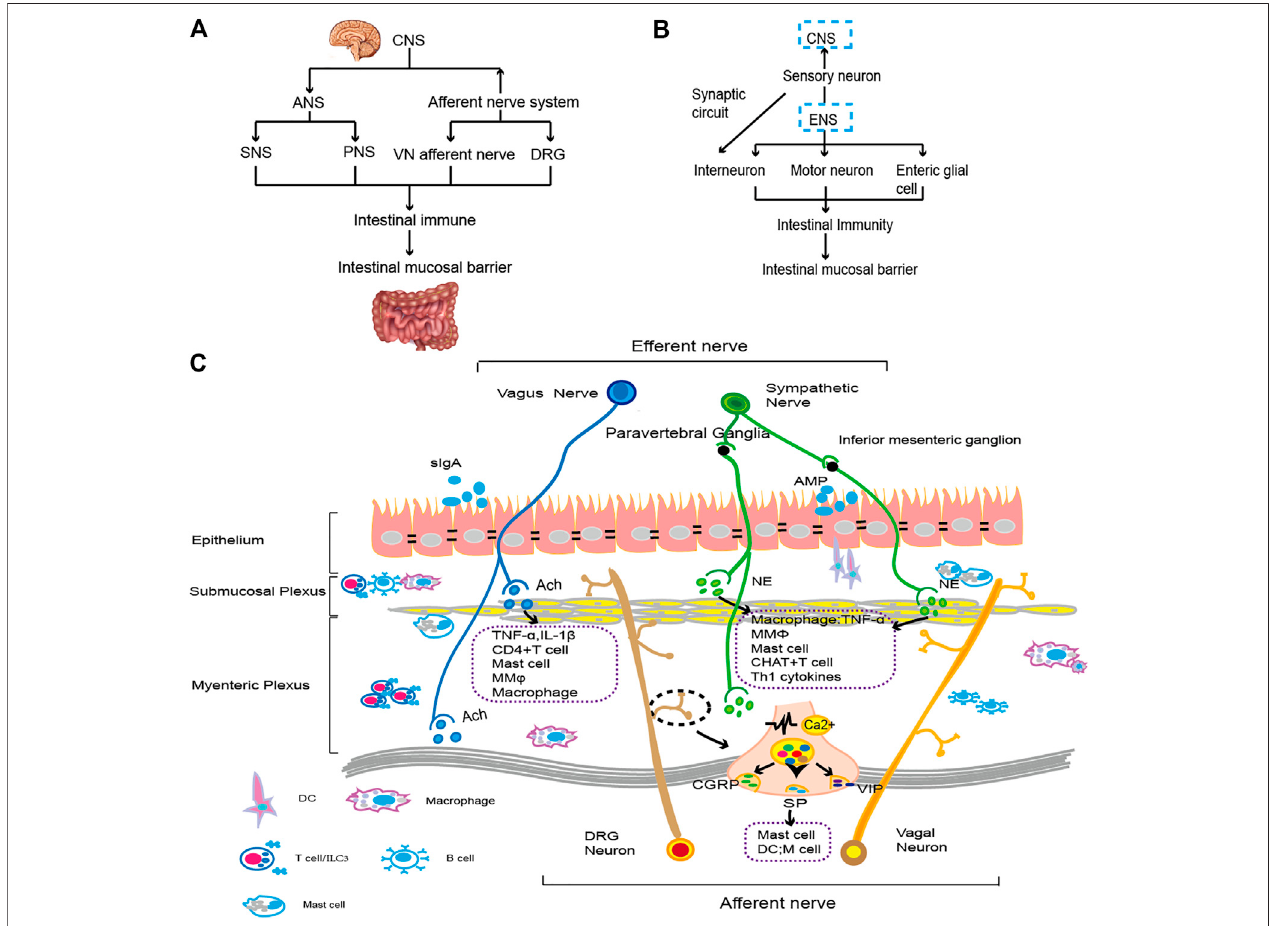
FIGURE 1 | The gut brain axis and neuroimmunity. (A) . The CNS connects with the intestine through the ANS and afferent nerves. By regulating immune cells and cytokines, itaffects the function ofthe intestinal epithelial cell barrier. The speci fi ctypes of immune regulation are shown in (C) . (B) . The ENS transmits information to the CNS through sensorynerves.Moreover,motorneurons, intermuscularneuronsandintestinalglialcellsoftheENS interact withintestinal resident orexogenousimmune cells and then affect the composition and function of the intestinal mucosal epithelial barrier. The speci fi c immune types are shown in (C) . (C) . ANS fi bers from the CNS extend into intestinal tissue. Sympathetic nerve fi bers bind to β 2-AR on immune cells by releasing NE. VN downregulates proin fl ammatory factors by regulating macrophages, preserving the function of intestinal epithelial goblet cells and Paneth cells (Brinkman et al., 2019). When external stimulation occurs, the vagal afferent nerve and spinal afferent nerve act on the intestine and release neurotransmitters, such as CGRP, SP, VIP, etc., and then activate immune cells, such as mast cells, to regulate cytokine levels, injuring the gastrointestinal mucosa (Lai et al., 2017). The motor neurons and glial cells in ENS primarily constitute the submucosal plexus and intermuscular plexus. They regulate proin fl ammatory factors with intestinal resident immune cells to monitor the status of intestinal epithelial cells and promote intestinal homeostasis (Furness, 2012; Vergnolle and Cirillo, 2018). A variety of nerve and immune groups interact to maintain the integrity of the intestinal epithelial cell layer and the normal function of